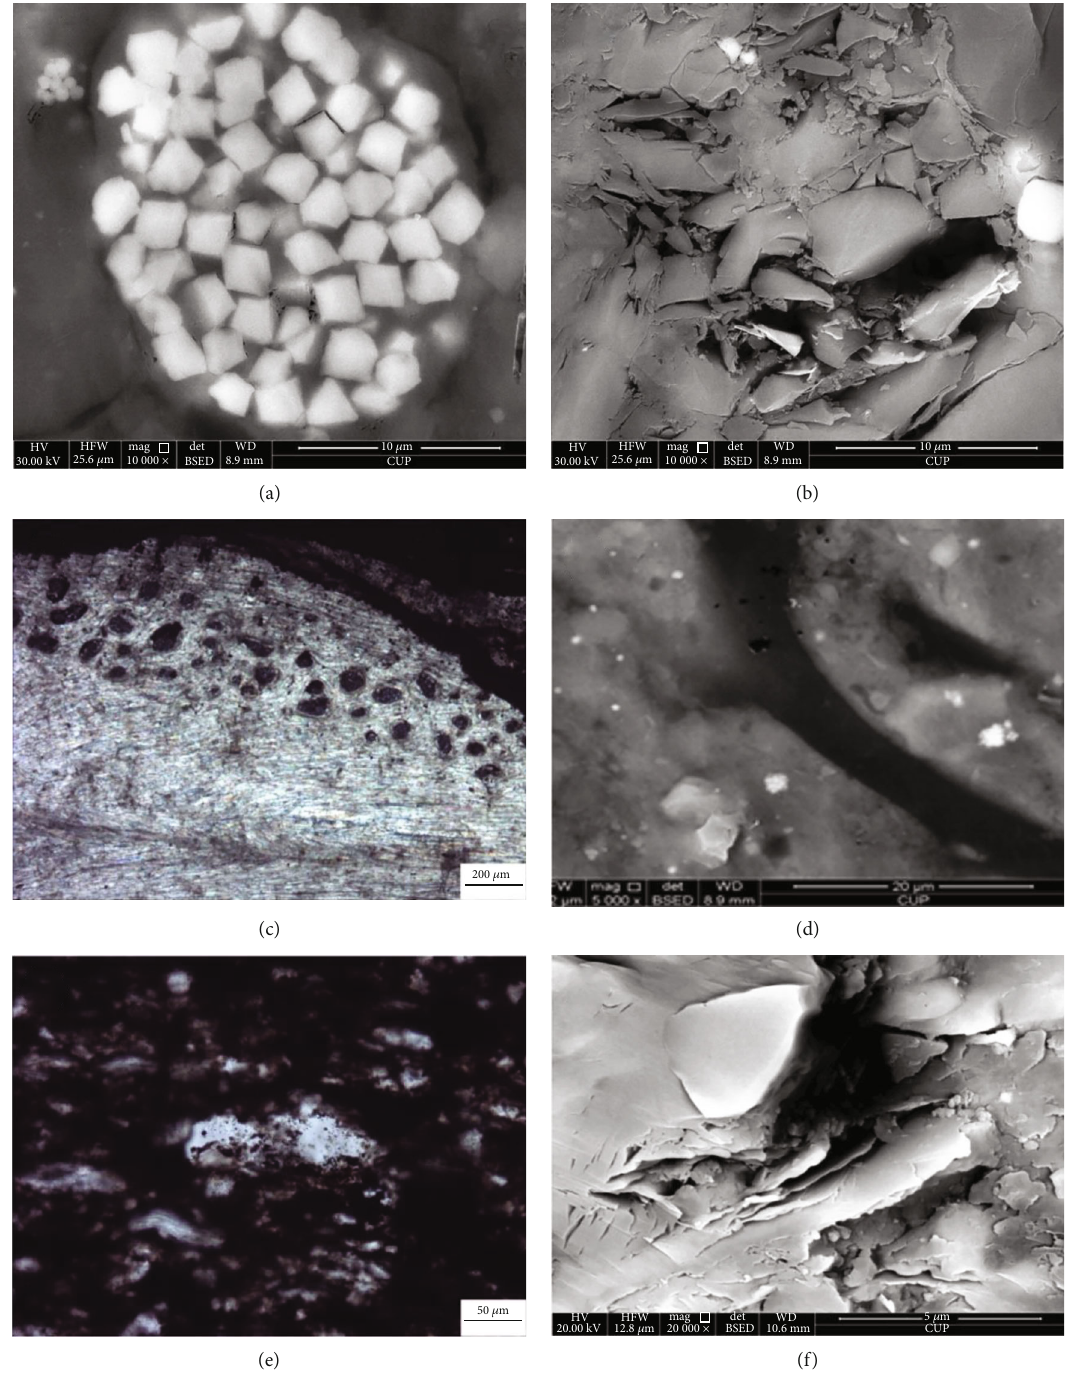
Figure 4: Types and microcharacters of the pores. (a) Intercrystalline pore of pyrite, SEM, 990.90m. (b) Intercrystalline pores of clay minerals, SEM, 997.15m. (c) Bioclastic grain endopore, (+)50 × , 1033.10m. (d) Organic matter grain inner pore, SEM, 990.90m. (e) Clay mineral dissolution pores, (-)200 × . (f) Inner particle dissolution pores, SEM,